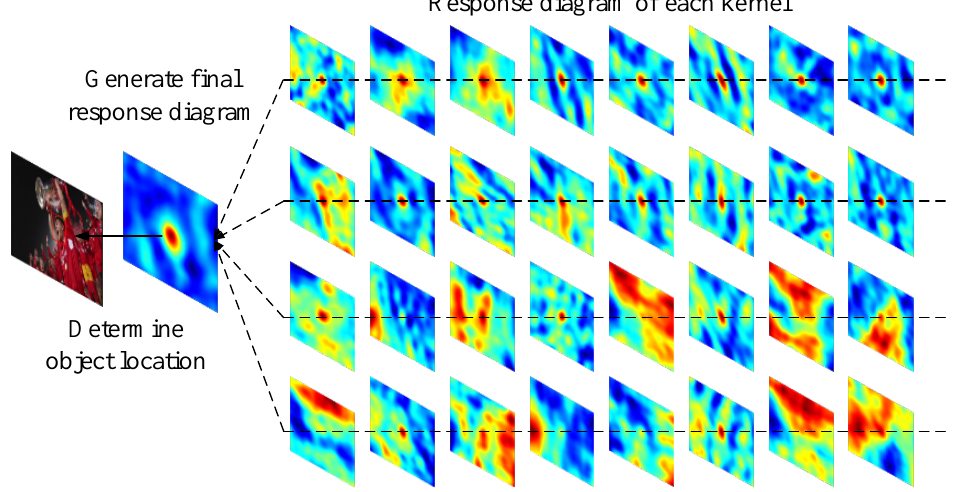
Figure 3. The response maps of different convolution kernels in response to the object’s position ( “ soccer ” video sequence).